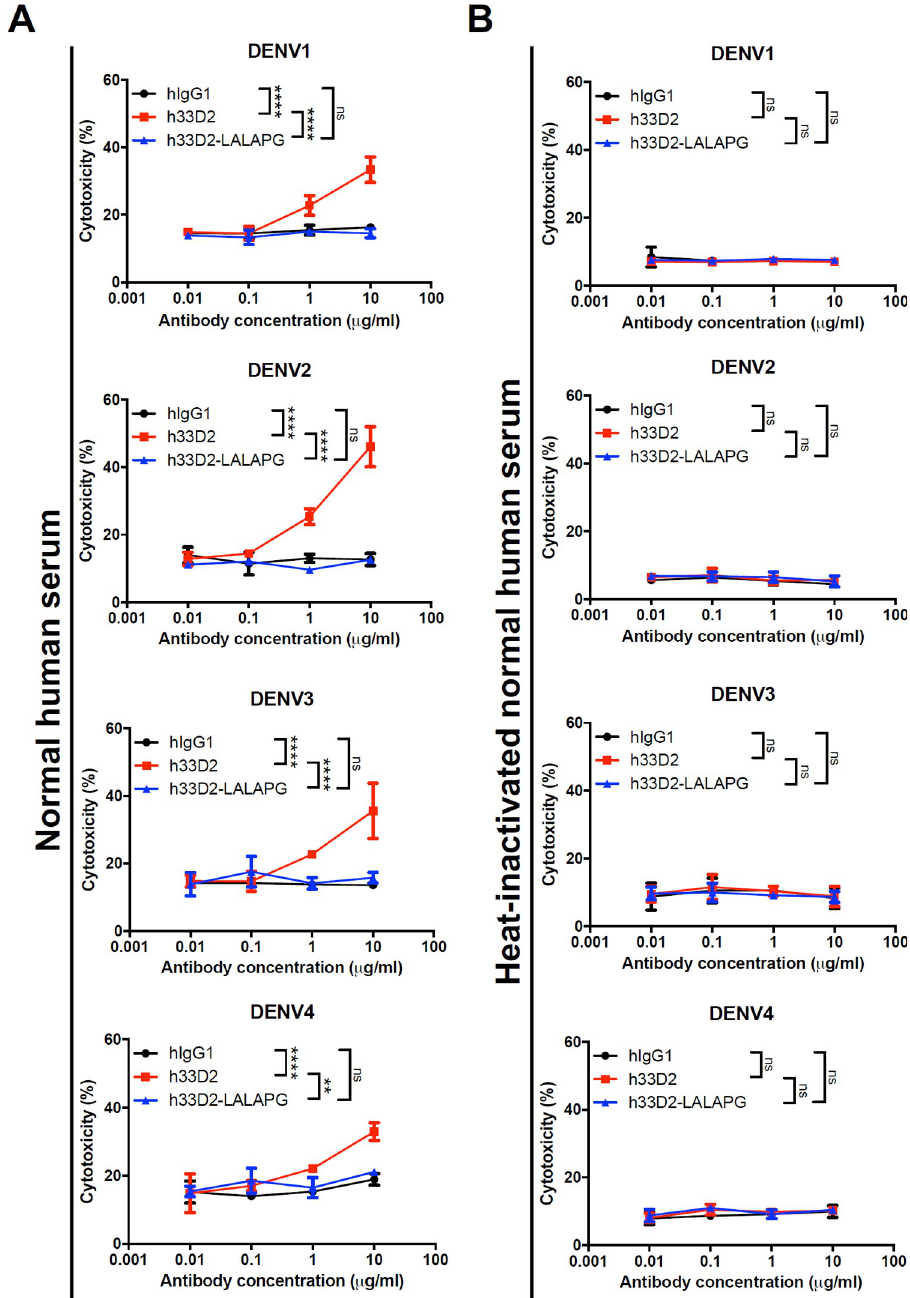
Fig 6. Fc-dependence of complement-mediated lysis of DENV-infected cells by humanized anti-NS1 mAb 33D2. Huh-7 cells were infected with DENV1-4 then using isotype control hIgG1, h33D2, and h33D2-LALAPG at 0.01, 0.1, 1, and 10 μ g/ml final concentrations to analyze ability to elicit CDC by using normal human serum (NHS) ( A ) or heat- inactivated NHS ( B ). The LALAPG variant preparation and the CDC assay were described in the methods. All data are presented as the averages of triplicate cultures ± S.D. �� : p < 0.01, ���� : p < 0.0001, ns indicates not significant. Statistical significance was based on two-way ANOVA followed by Tukey’s multiple comparison test.